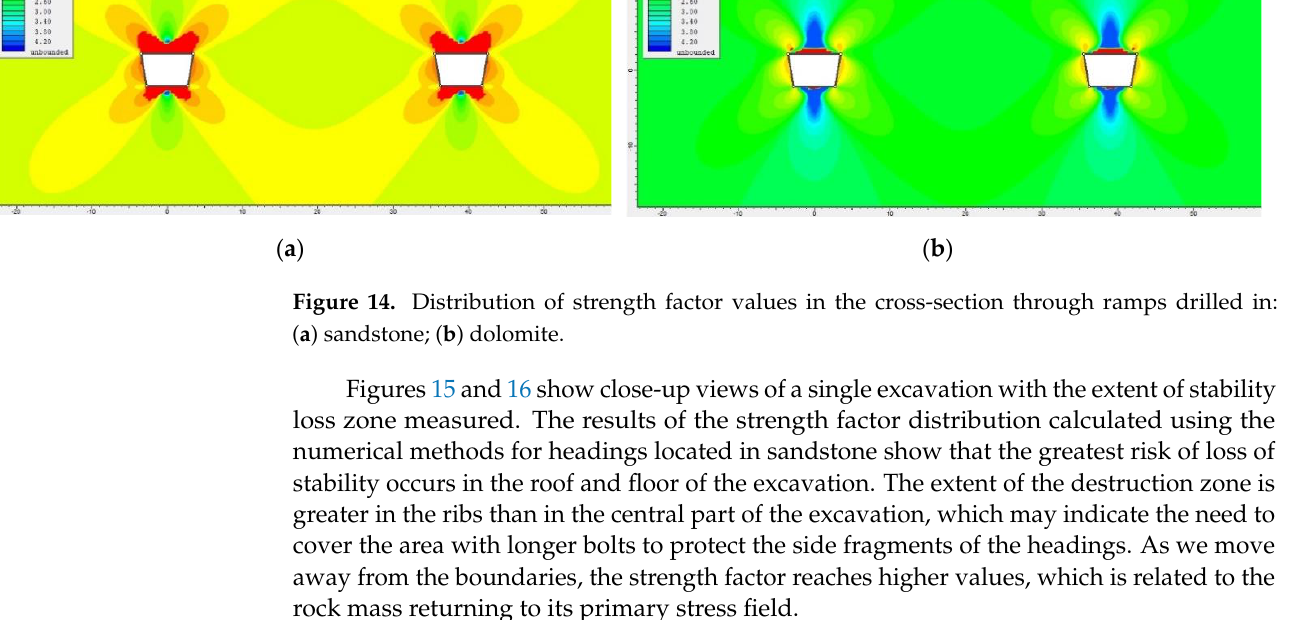
Figure 15. Distribution of strength factor values in the cross-section through ramps drilled in sandstone: ( a ) view of both headings; ( b ) close-up of a single excavation.